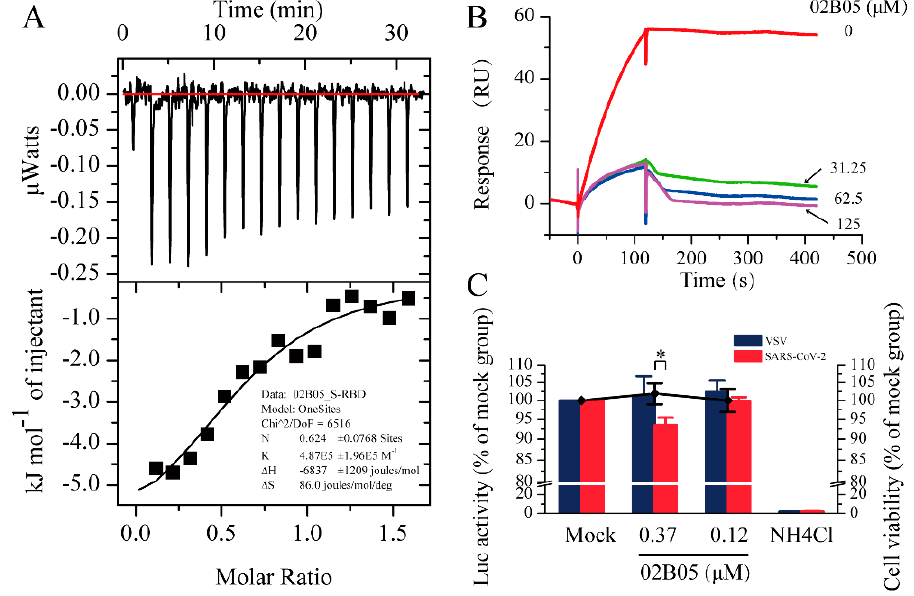
Figure 4. The results of Isothermal Titration Calorimetry (ITC), surface plasmon resonance (SPR)